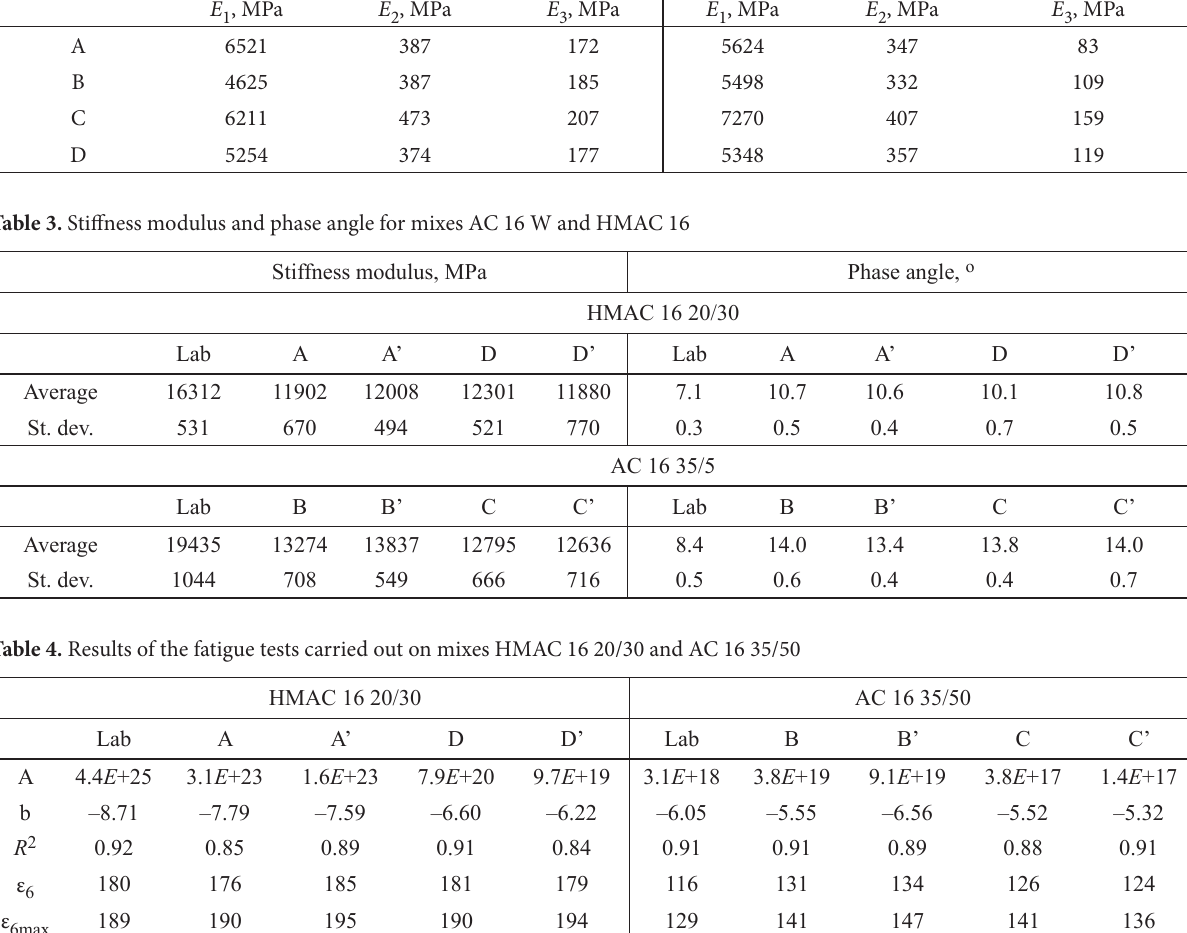
Table 2. Stiffness modulus evaluated from FWD tests Section